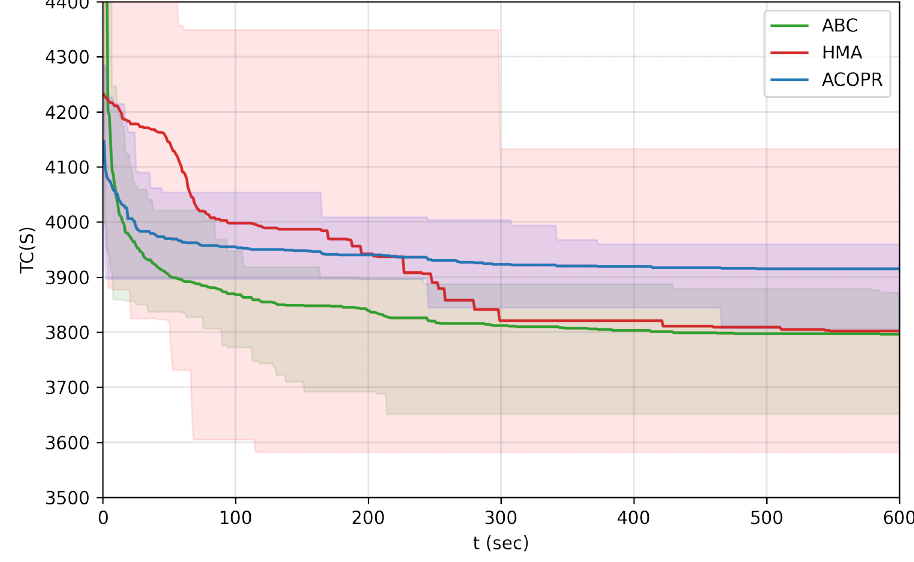
Figure 8. The convergence speed of 30 independent runs of HMA, ACOPR, and ABC algorithm on the “egl-e1-A” instance, plotted on one chart, with time limit ( t ≤ 600